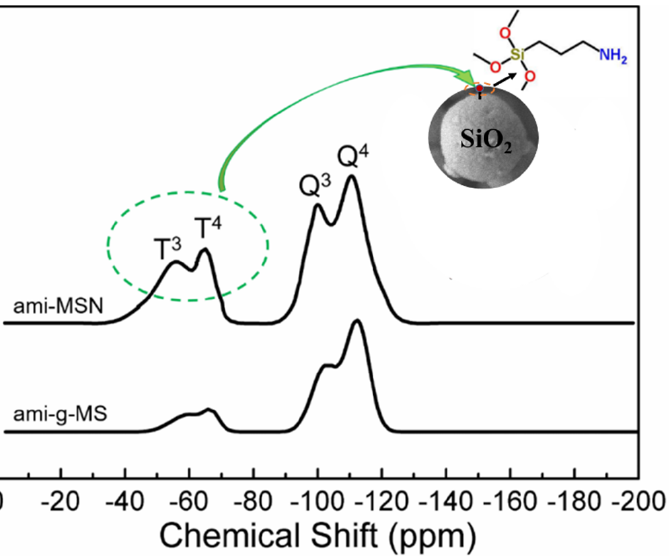
Figure 3. 29 Si MAS-NMR spectra of the amino-functionalized mesoporous silica. The spectra curves were treated using Guassian multi-peaks fitting. Table 1. Elemental analysis of ami-g-MS and